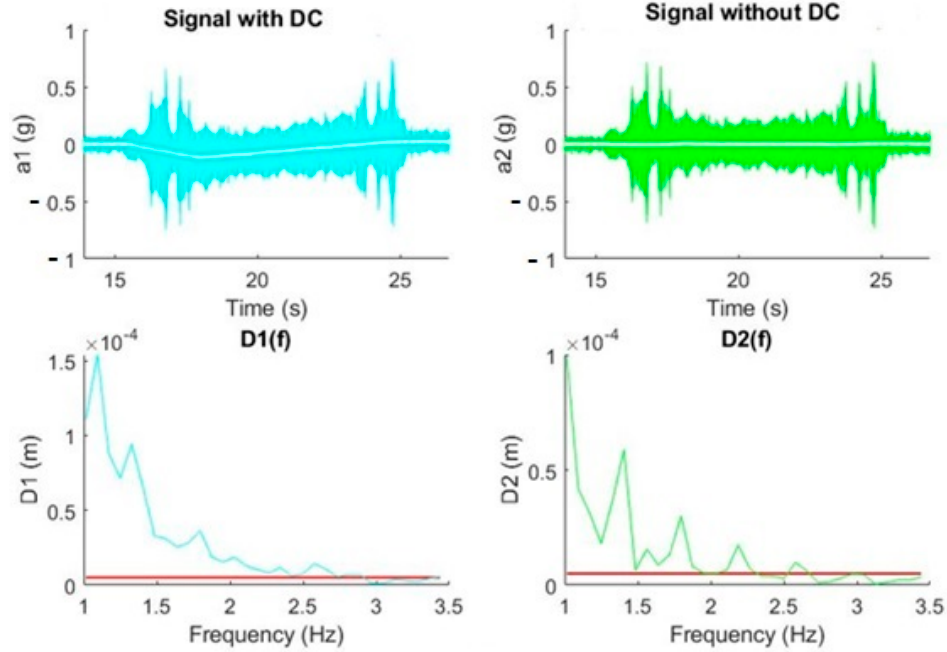
Figure 9. DC removal effect on a real signal (declination movement from 0° to 40°). The red line in the graphs establishes the maximum value of the